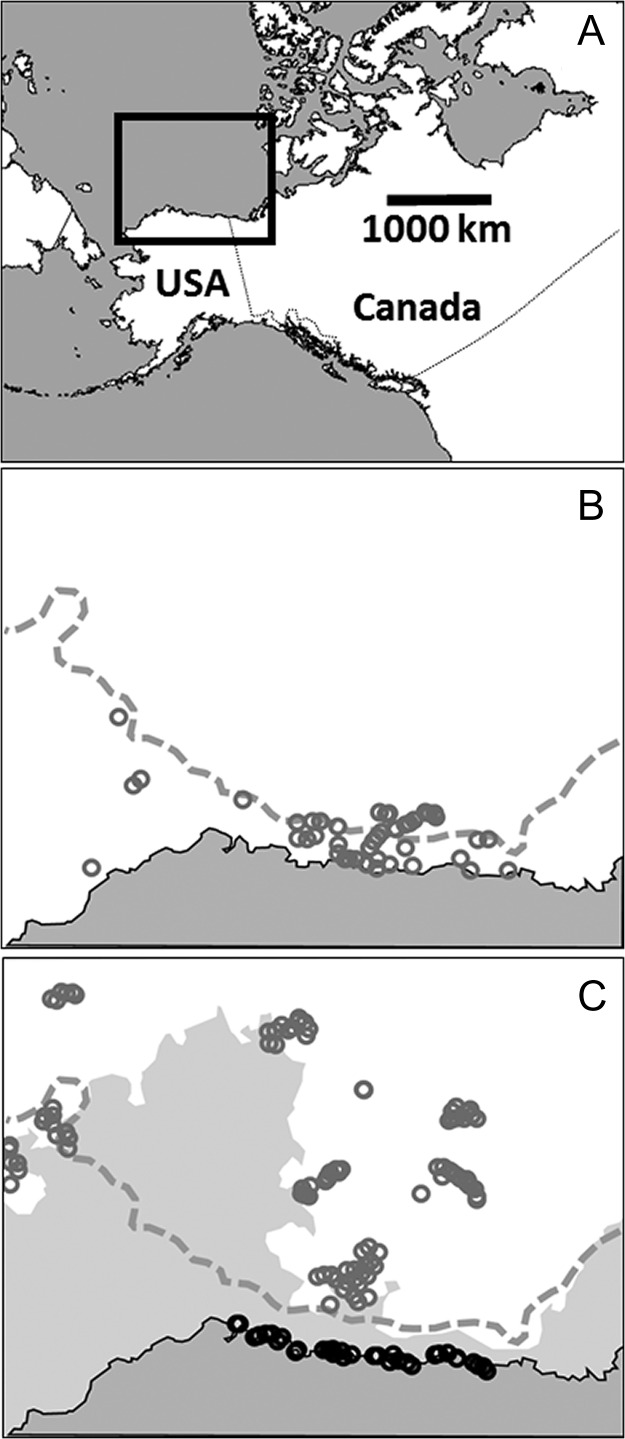
Maps of the study area in the Arctic. (A) The Beaufort Sea region (boxed). (B) The Beaufort Sea region, Alaskan (USA) coast (dark gray), 300 m bathymetric contour (dashed gray line), and distribution of sea ice (white) as of 11 May 2009. Gray circles are locations (estimated error <250m) from 24 polar bears over the previous week. (C) The same area with distribution of sea ice as of 31 August 2009. Circles are locations of 31 polar bears over the previous week, exemplifying ‘ice’ (gray) and ‘shore’ (black) individuals. Ice data from National Snow and Ice Data Center (https://nsidc.org/).